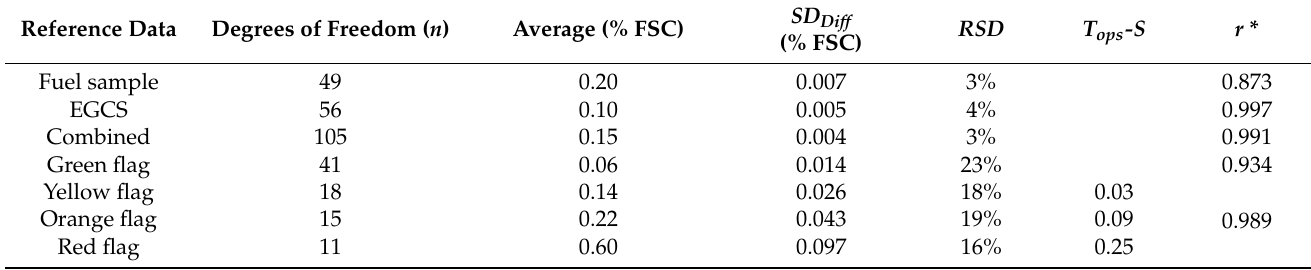
Table 3. Comparison of airborne data with reference data from EGCS and Fuel